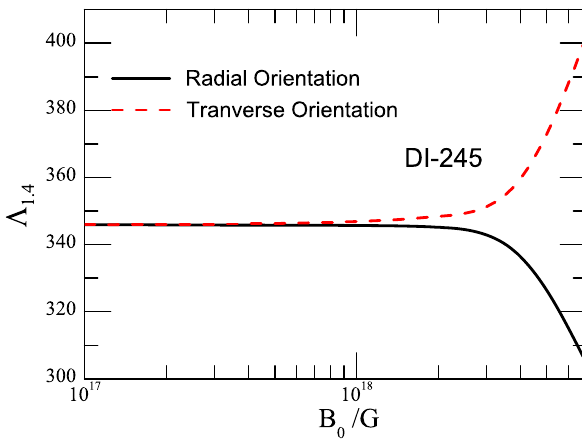
Fig. 3 Mass-radius relation at zero magnetic fields